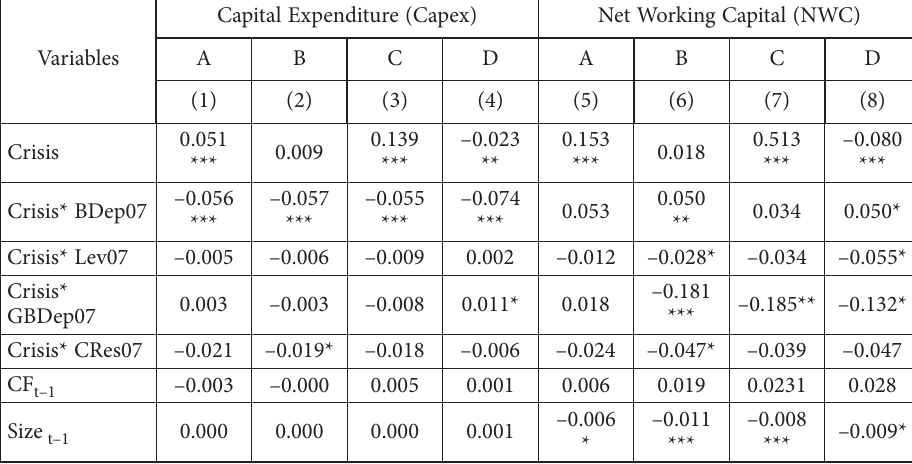
Table 6. Tests of robustness on investment changes after the financial crisis Capital Expenditure (Capex) Net Working Capital Variables